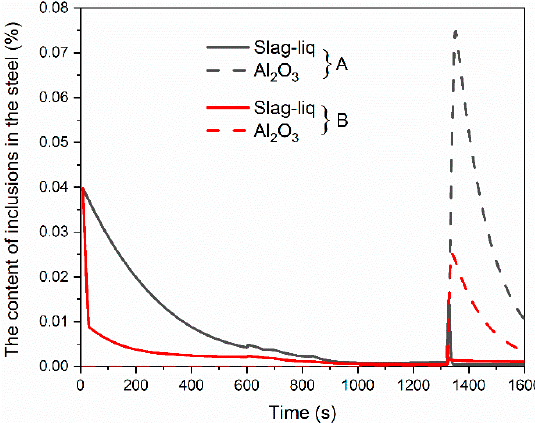
Figure 7. Comparing ( a ) the mass of slag phases and ( b ) MgO solubility in the liquid slag [21].